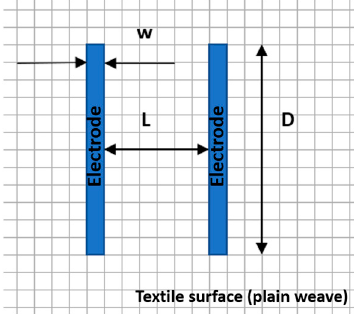
Figure 1. Placement of the parallel electrodes on the same side of the textile surface for surface resistance measurement (w represents the width of the electrode, D represents the length of the electrode (D = 6 cm), and L is the distance between electrodes (L = 3 cm)). The surface morphology was evaluated using scanning electron microscopy (Quanta